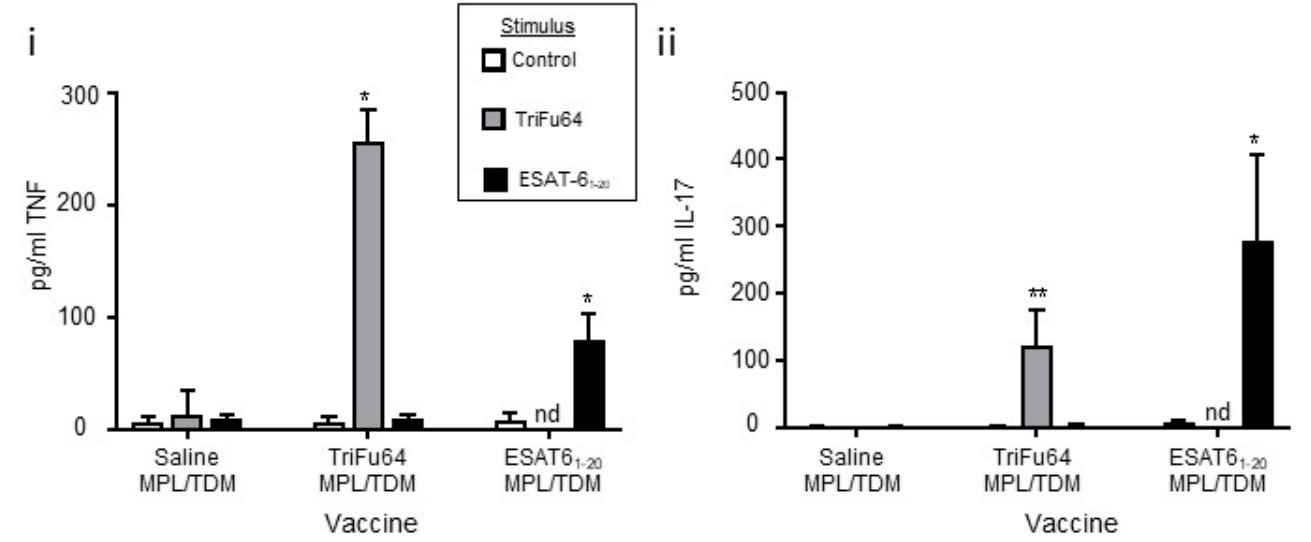
Figure 4. Induction of differential antigen-specific cellular responses by MPL/TDM/DDA adjuvanted antigens. Mice were vaccinated as described for Figure 3iii and then humanely killed 15 days post vaccination. Splenocytes from vaccinated mice were cultured either without stimulus (open bars) or with TriFu64 (light gray bars) or ESAT6 1-20 (black bars). The supernatant was collected after 24 h of culture and analyzed for the cytokine’s TNF α ( i ) or IL-17 ( ii ) by ELISA. Data shows 1 experiment representative of 2 total with n = 4 for each. Significance of differences between means was determined by ANOVA and Kruskal Wallis comparison to control stimulus (* p ≤ 0.05 , ** p ≤ 0.01).